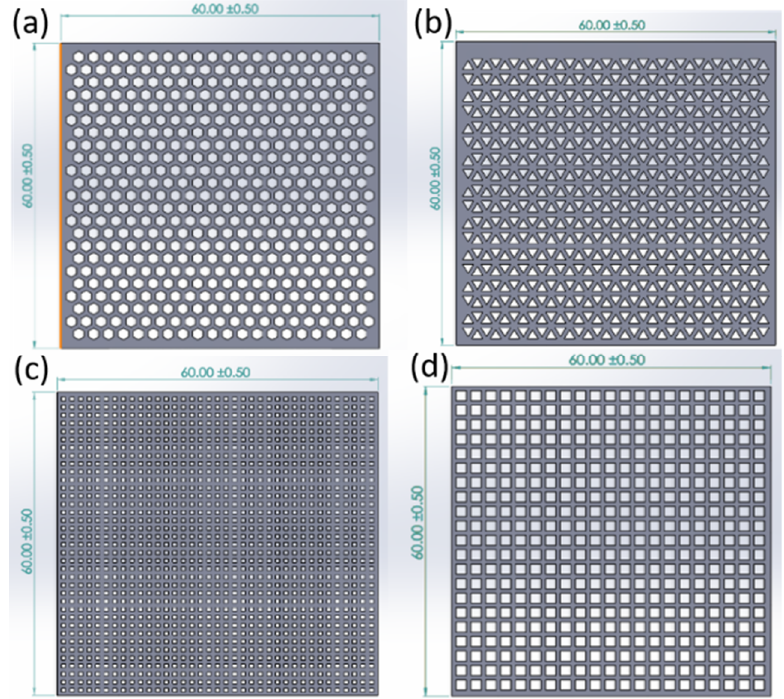
Figure 1. Computer-aided design (CAD) of curcumin-loaded scaffold (60 × 60 mm) with different pore types: ( a ) honeycomb, inner circle diameter = 2.0 mm; ( b ) triangle, inner circle diameter = 1.2 mm; ( c ) square 1, inner circle diameter = 0.8 mm and ( d ) square 2, inner circle diameter = 2.0 mm. Table 3. Surface area, volume, and Surface to Volume (S:V) ratio of digital scaffold models with different pore shapes (honeycomb, triangle, square 1, and square 2) and thicknesses (0.1, 0.2, and 0.4 mm). Honeycomb Parameter Surface area (mm 2